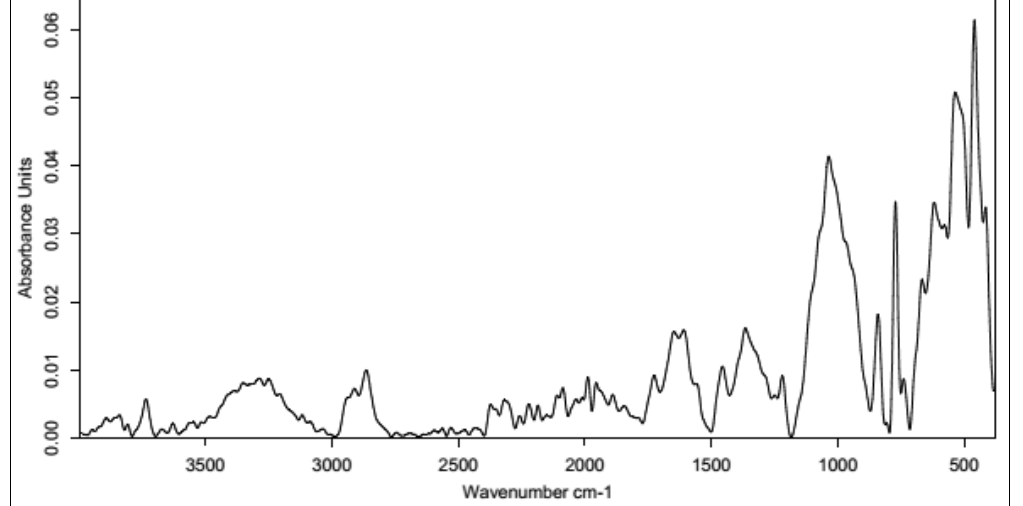
Figure 14. IR spectrum for hyaluronic-acid-coated carbon nonwoven samples cross-linked with BDDE.